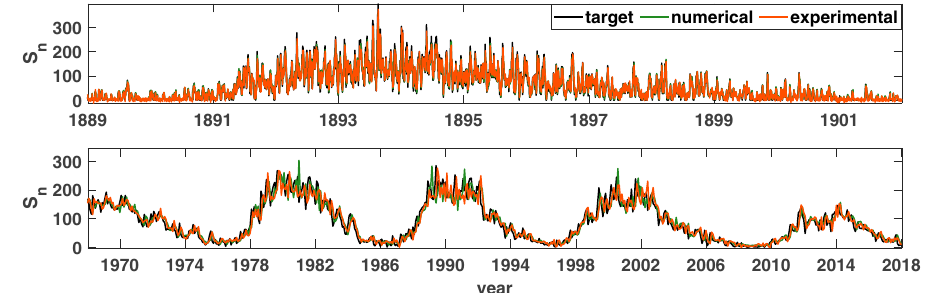
Figure 12. Comparison of the performance the sunspot prediction ( S n ) task. Top: Daily total number of sunspot prediction task, for both the experiment and the numerical simulations. Performance metric: NMSE exp = 0.0548 , NMSE sim = 0.0534 . Bottom: Monthly mean total number of sunspot prediction task. Performance metric: NMSE exp = 0.0595 , NMSE sim = 0.0455 . Parameters were set such that: V µ = µ = 5 volts, A = 0.5 volts, � = 40 π rad/s, V ω 0 = ω 0 = 40 π rad/s, N = 1000 nodes, φ = π/ 3 rad, σ = 15 volts, β = 1.0 volts. Only a portion of the result is shown in each